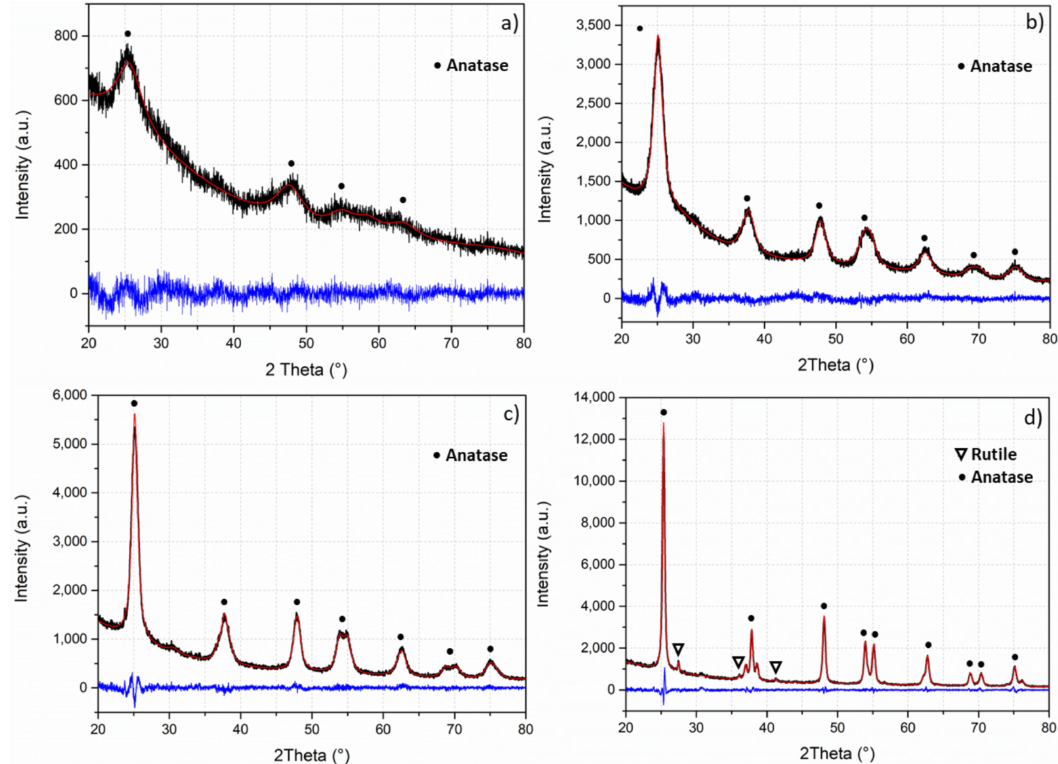
Figure 1. Experimental XRPD patterns refined by Le Bail method for ( a ) TiO 2 -acetylacetone (ACAC); ( b ) TiO 2 -ACAC-300; ( c ) TiO 2 -ACAC-400 and ( d ) TiO 2 -ACAC-550. The experimental pattern is black, the calculated pattern is red and the difference plot is blue.